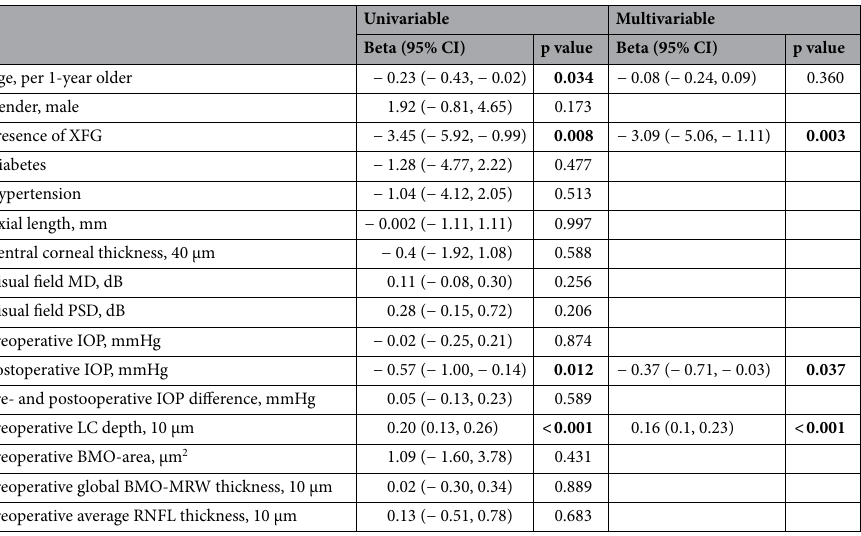
Table 3. Factors associated with the degree of lamina cribrosa shallowing (per 10 µm) after trabeculectomy. XFG exfoliation glaucoma, MD mean deviation, PSD pattern standard deviation, dB decibel, IOP intraocular pressure, LC lamina cribrosa, BMO-MRW Bruch’s membrane opening-minimum rim width, RNFL retinal nerve fiber layer. Beta coefficients were calculated based on the 10 µm decrease in the lamina cribrosa depth. Statistically significant p-values are shown in bold.